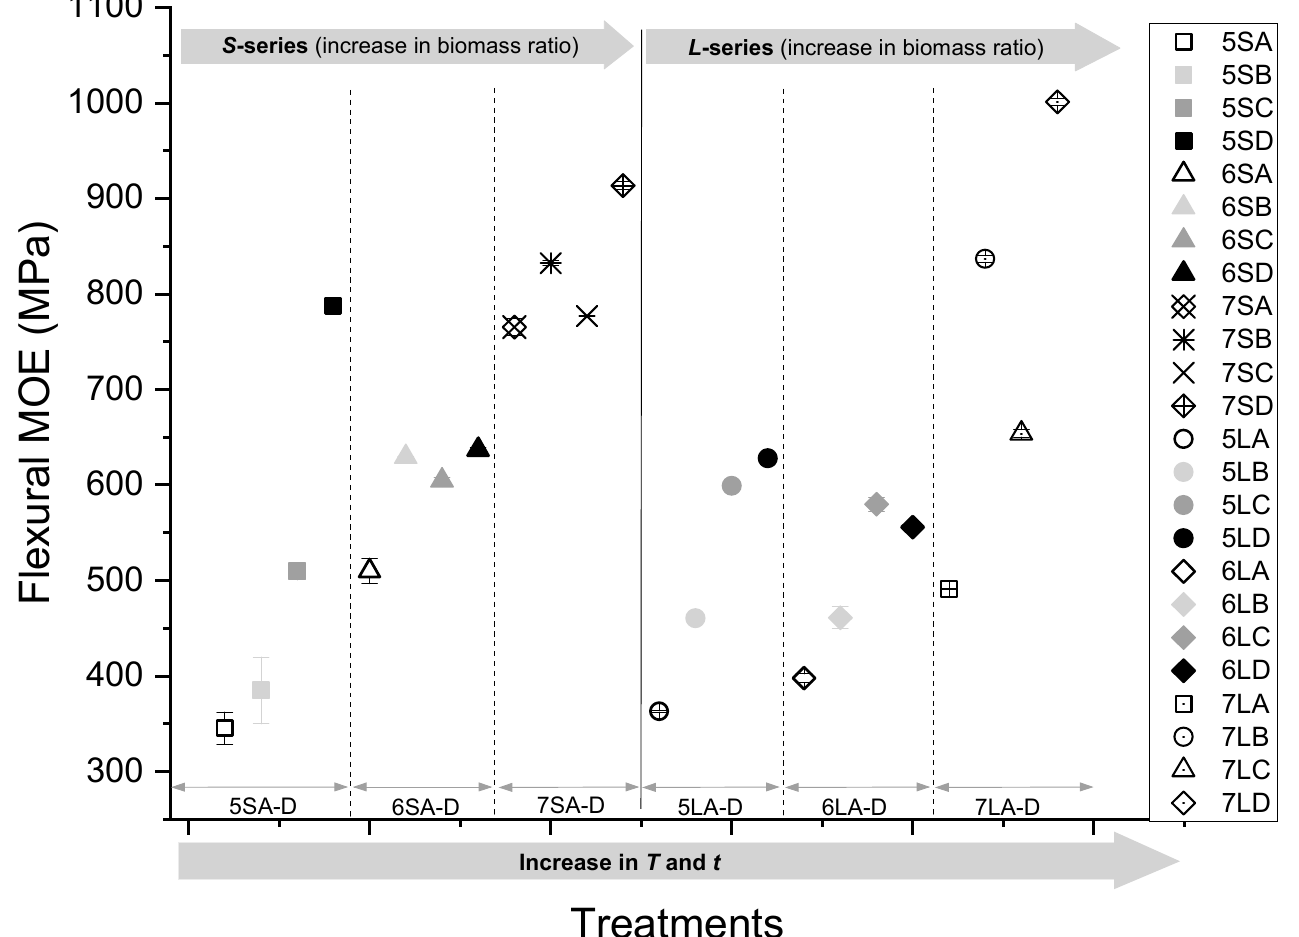
Figure 11. Flexural MOE of the WPCs pressed at different temperatures and times (A–D) with 50, 60, and 70% biomass at two particle sizes ( S and L ).